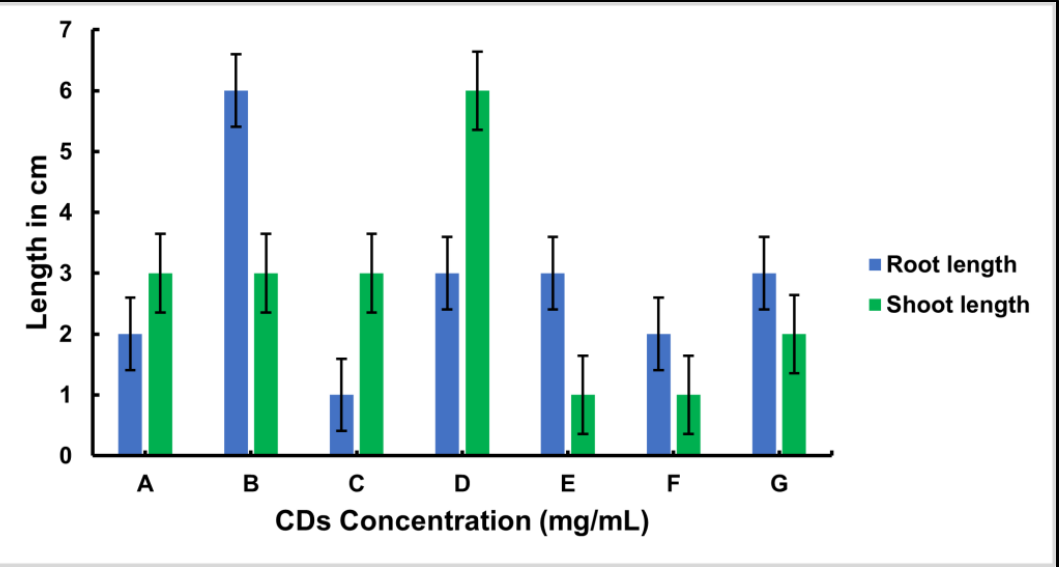
Figure 7. Effect of fluorescent CDs on Germinating seeds of Mung bean ( V. radiata (L.)) after 8 Days of incubation. Error bars indicate the uncertainty or errors in the measurements reported. Where A, B, C, D, E, F, and G refer to the treatment of germinating seeds with CDs at concentrations of 1, 2, 4, 8, 12, 16 mg/mL, and untreated (the control) seeds,